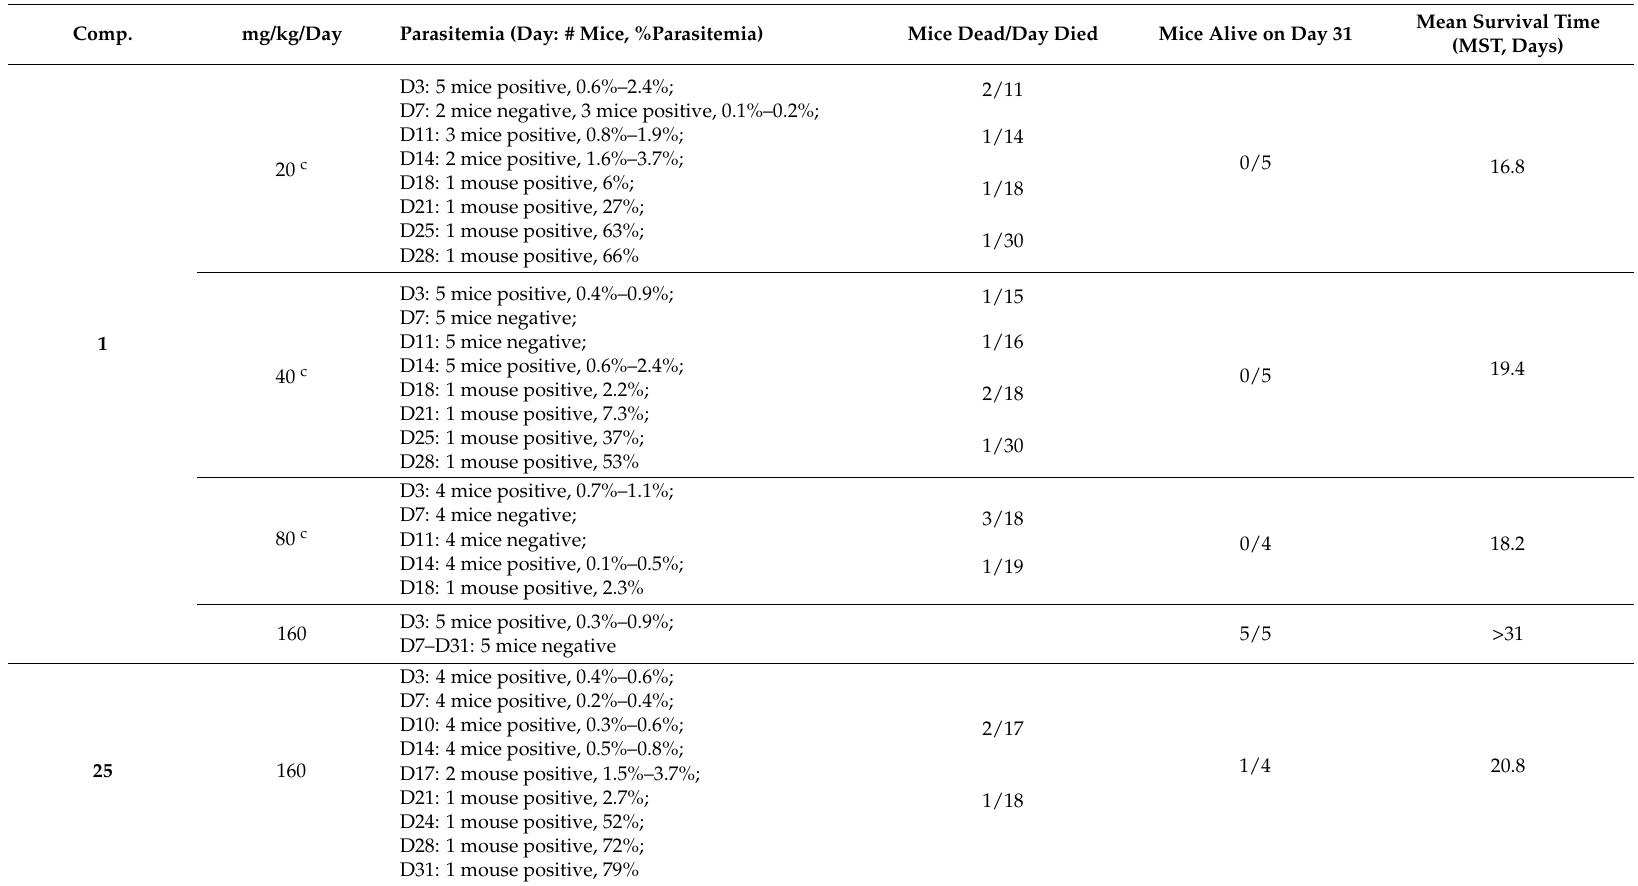
Table 3. In Vivo Antimalarial Activity a,b